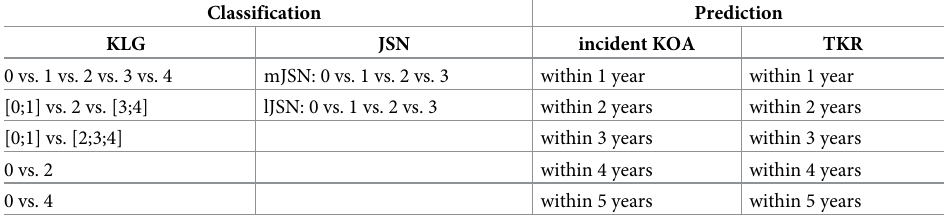
Table 2. Analyses performed to investigate the suitability of features to describe different aspects of KOA. Features are employed to classify between KLGs, grades of joint space narrowing (JSN), as well as to predict incident KOA and total knee replacement